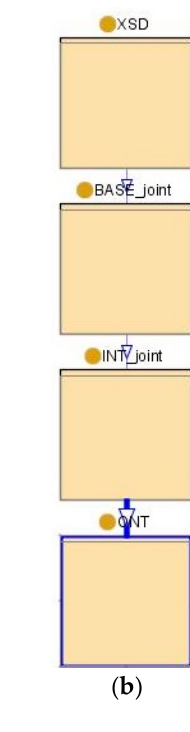
Figure 8. Simplified node structure and ontology import: ( a ) partial simplification, ( b ) full Figure8. Simplifiednodestructureandontologyimport: ( a )partialsimplification, ( b )fullsimplification. simplification. Table 1. Development tuples of subgraphs of the “units” ontology.